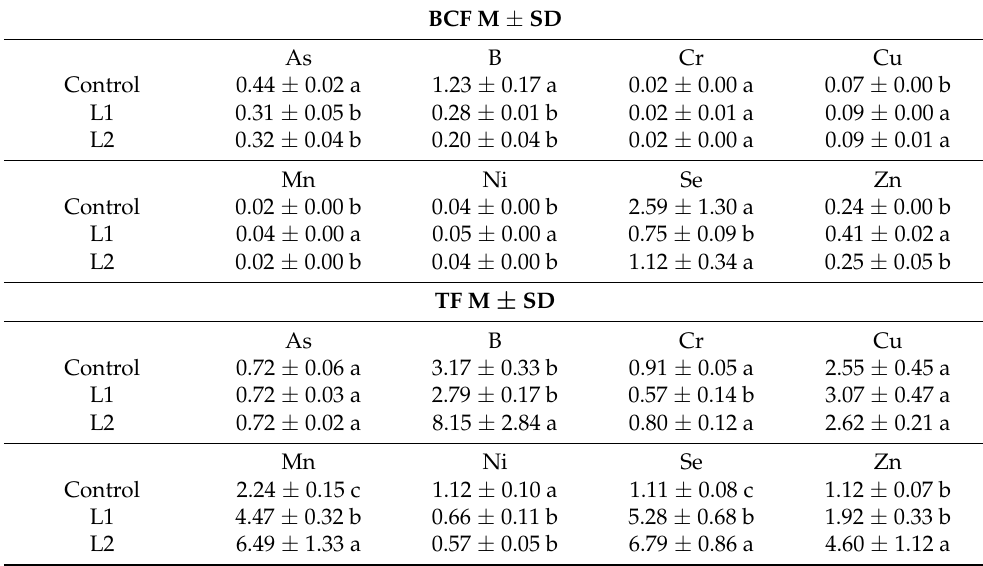
Table 3. Bioconcentration (BCF) and translocation (TF) factors for T. tetrandra on fly ash (L1 and L2) and soil